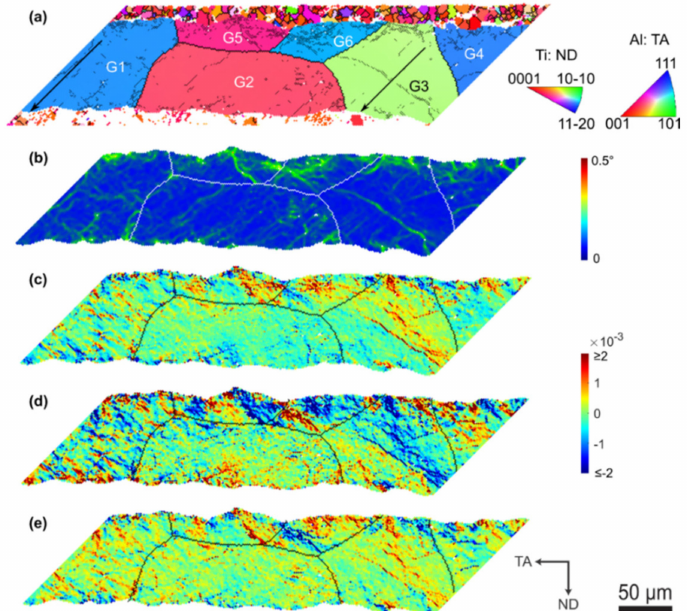
Figure 2. The initial state before tensile loading. ( a ) Inverse pole figure coloring map with separate color codes for Ti and Al; grain boundaries with misorientation angles larger than 15 ◦ are shown by thick lines for both Ti and Al, and boundaries between 0.1 ◦ and 15 ◦ are shown by thin lines for Al (adapted from [8]). ( b ) Local misorientation angle map for the six Al grains. ( c – e ) Maps of deviatoric strains along the TD, tensile axis (TA) and normal direction (ND),